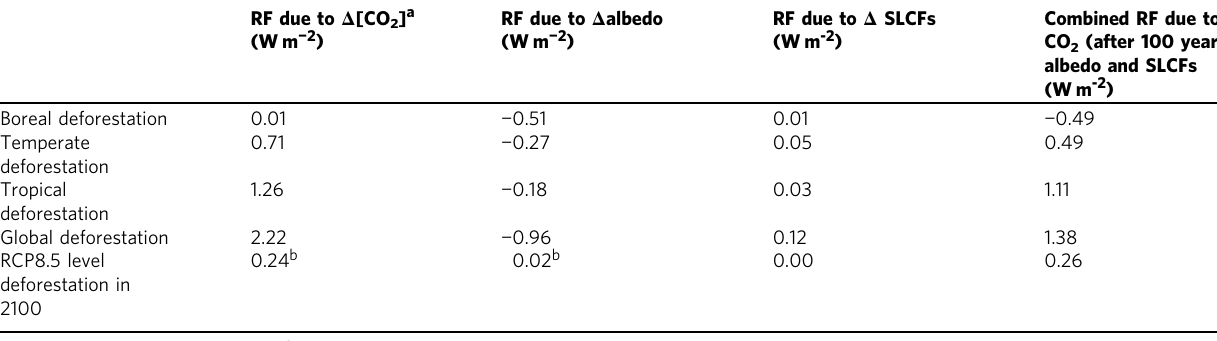
Table 1 Summary of global annual mean radiative forcings due to idealised deforestation scenarios